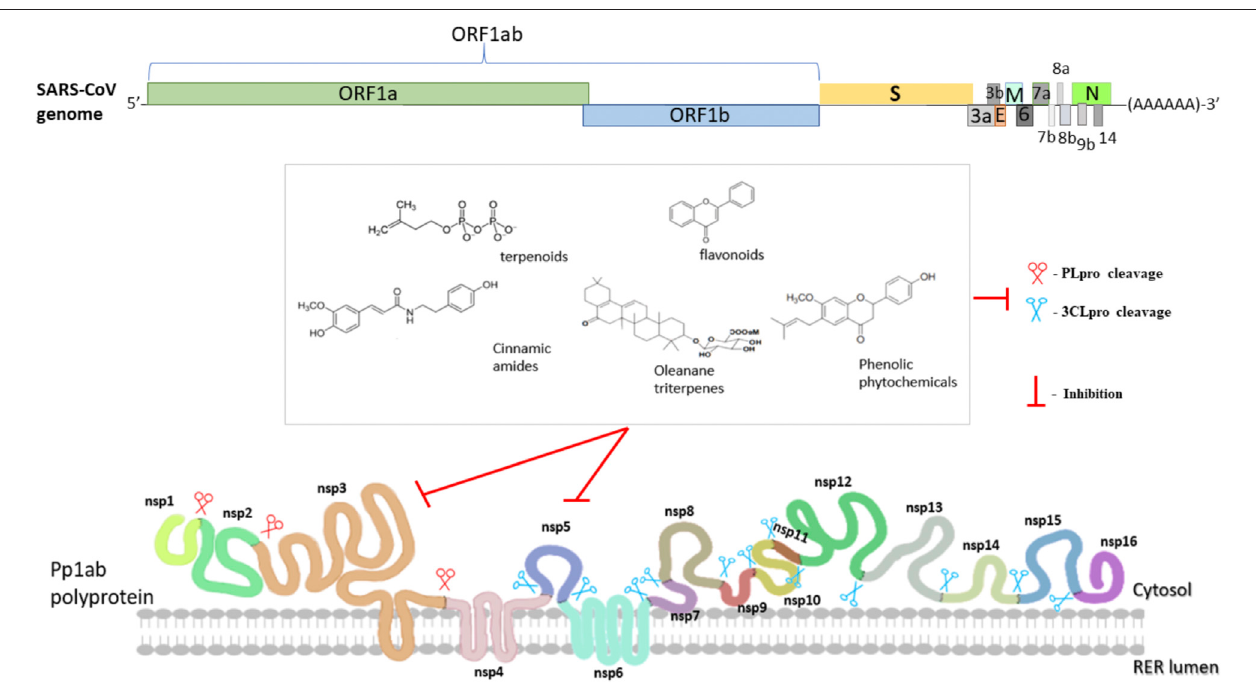
FIGURE2| SchematicdiagramofSARS-CoV-2virusgenomeorganization and viralproteases inhibition bynaturalcompounds. The complete genomesequence is ∼ 30 kb long. Two viral proteases (PLPro and 3CLPro) are responsible for cleaving polyproteins into the functional individual Nsps such as helicase, RDRP and methylases. Nsp3 also known as PLPro is a papain like protease that cleaves Nsp1/Nsp2, Nsp2/Nsp3 and Nsp3/Nsp4 boundaries whereas Nsp5 also known as Mpro or 3CLProis aserine likeprotease catalyzingthe rest11cleavage reactions. Table 3 shows thenatural compounds that areknownto inhibit these viral proteases.